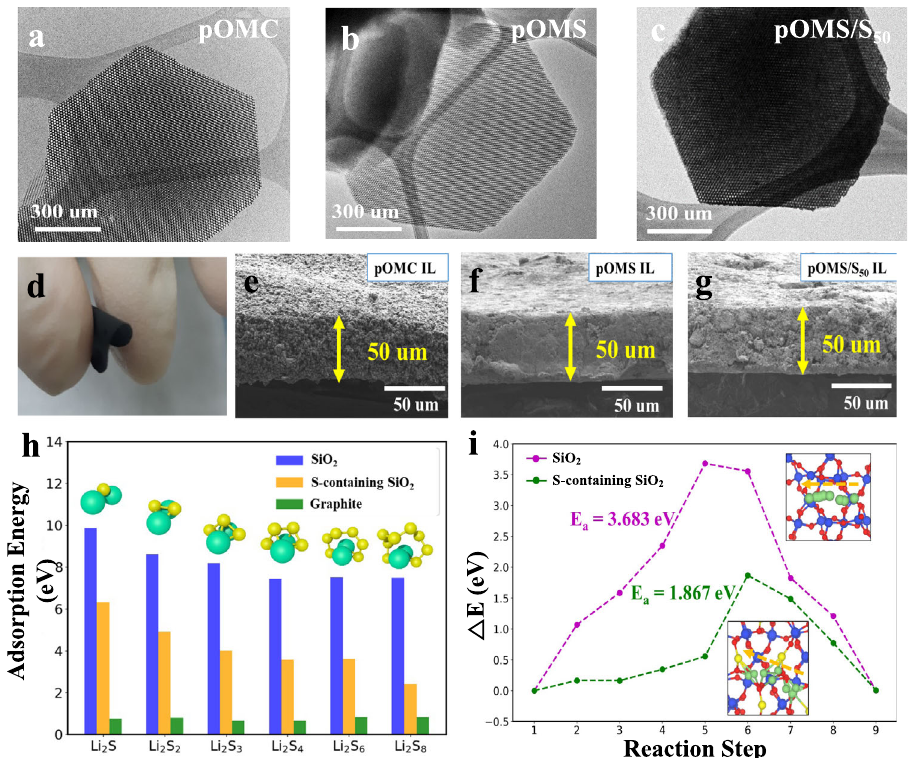
Fig. 2 Physicochemical and theoretical characterizations of the interlayers. a – c TEM images of ( a ) pOMC, ( b ) pOMS, and ( c ) pOMS/S 50 composite. d Digital photograph of pOMS IL showing its fl exibility. e – g Cross-sectional SEM images of ( e ) pOMC, ( f ) pOMS, and ( g ) pOMS/S 50 ILs. h Calculated adsorption energies of Li 2 S x (x = 1, 2, 3, 4, 6, and 8) on SiO 2 (blue), S-containing SiO 2 (orange), and graphite (green). i Potential energy pro fi les of Li-ion diffusion along different reaction steps on the surface of the SiO 2 and S-containing SiO 2 . (Inset is minimum energy path for Li-ion diffusion on SiO 2 and S-containing SiO 2 ).